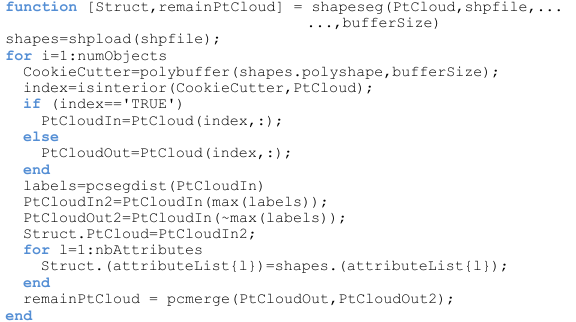
Figure 1. Pseudocode of the developed